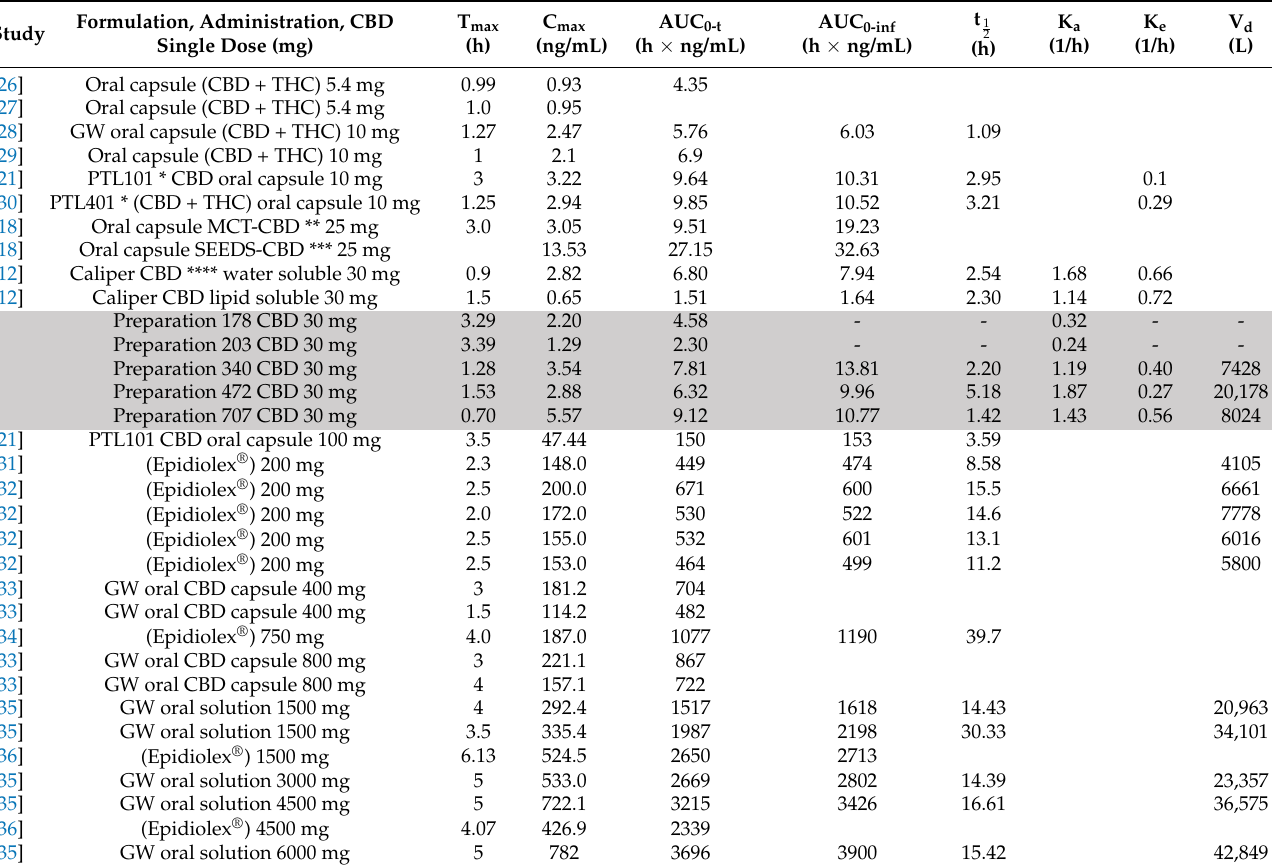
Table 6. Comparison of pharmacokinetic parameters of current preparations with previously reported studies of ingestible